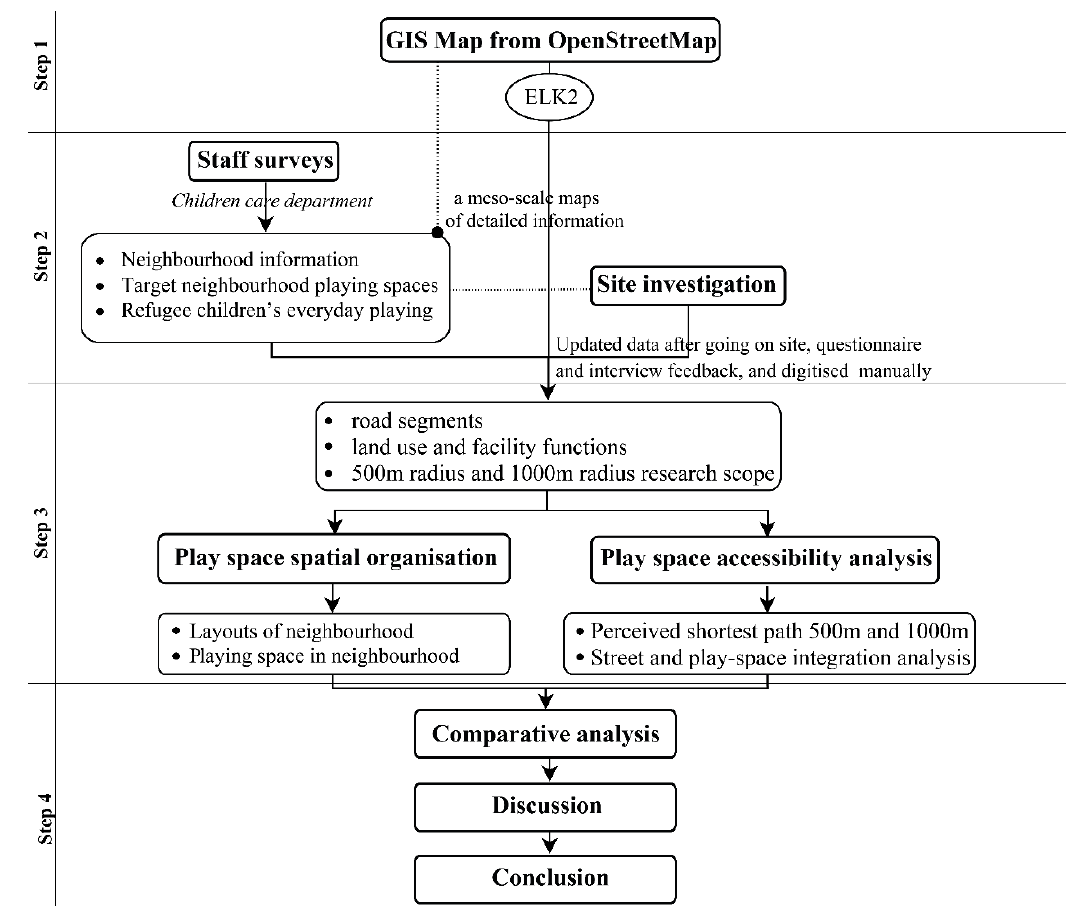
Figure 2. Overview of meso-environments approach including data sources, steps, technical methods and outputs.